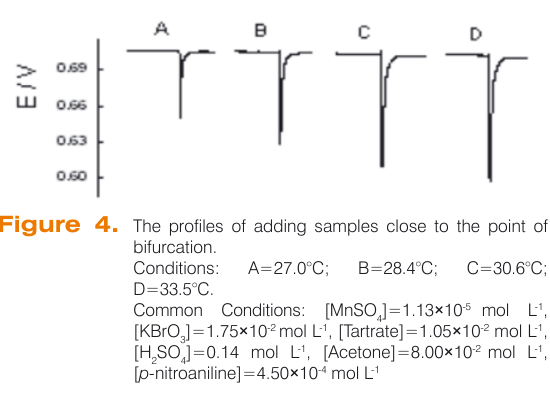
Figure 3. The plot of square of the amplitude vs. temperature.